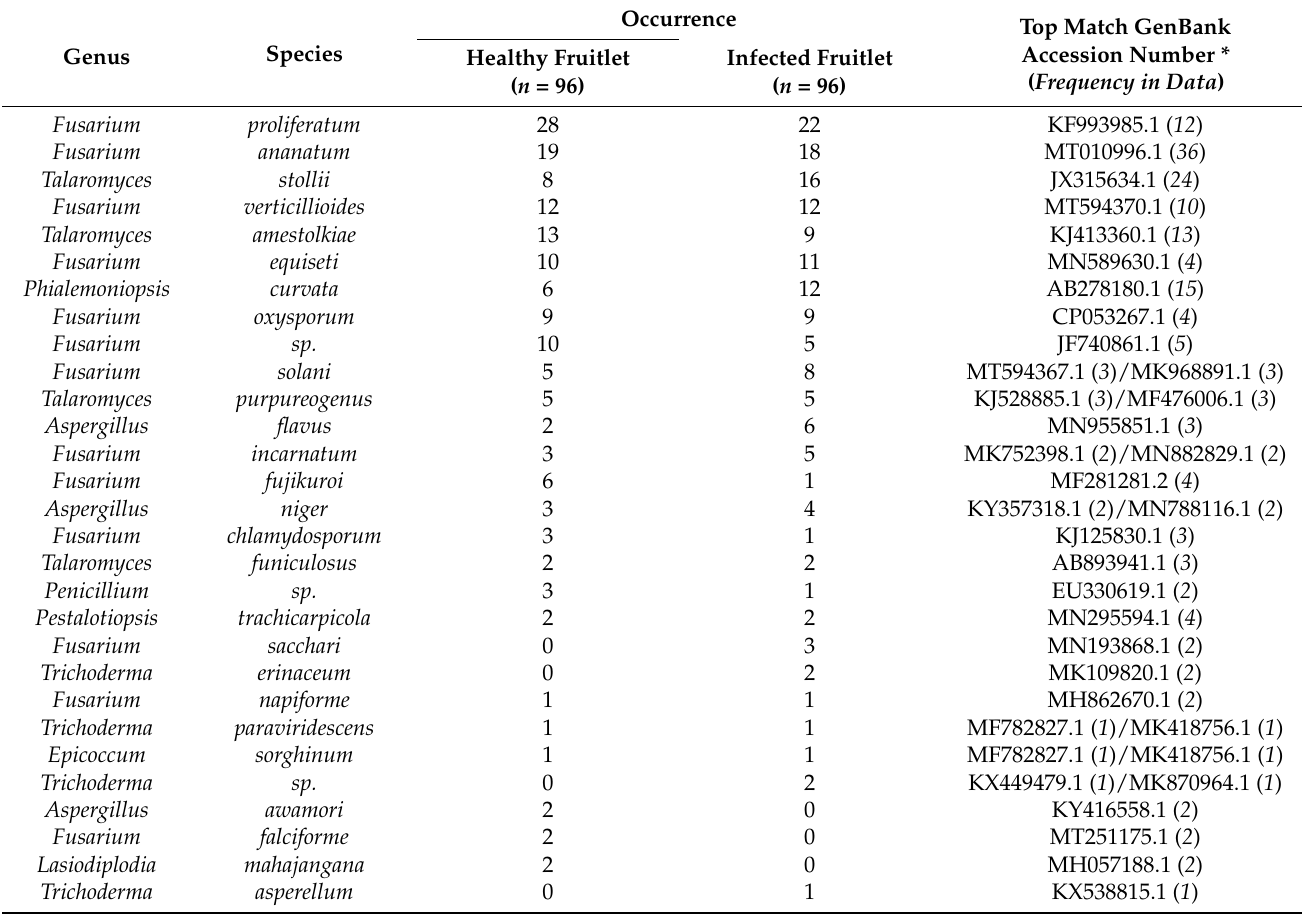
Table 3. Identification of fungal species and their respective occurrence in healthy and naturally infected fruitlets. Genus Species